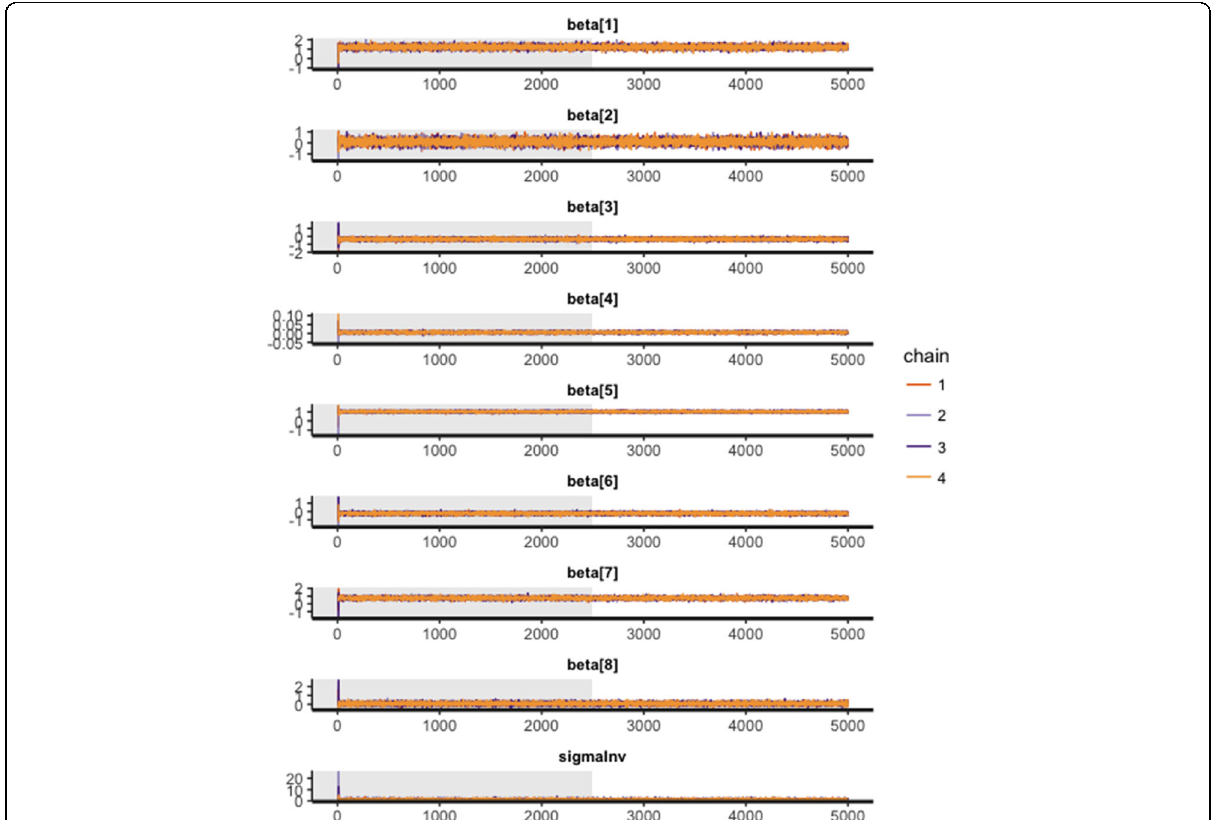
Fig. 5 Trace plots for the student analysis. The beta parameters (1 – 8) correspond to the regression coefficient of the intercept, college calculus, no previous calculus, standardized test percentile, reports of student-centered practices, females, ability to succeed, and success perception, respectively. The grayed iterations indicate those iterations that were removed from the analysis for burn-in. None of the plots suggest problems with convergence of the Markov